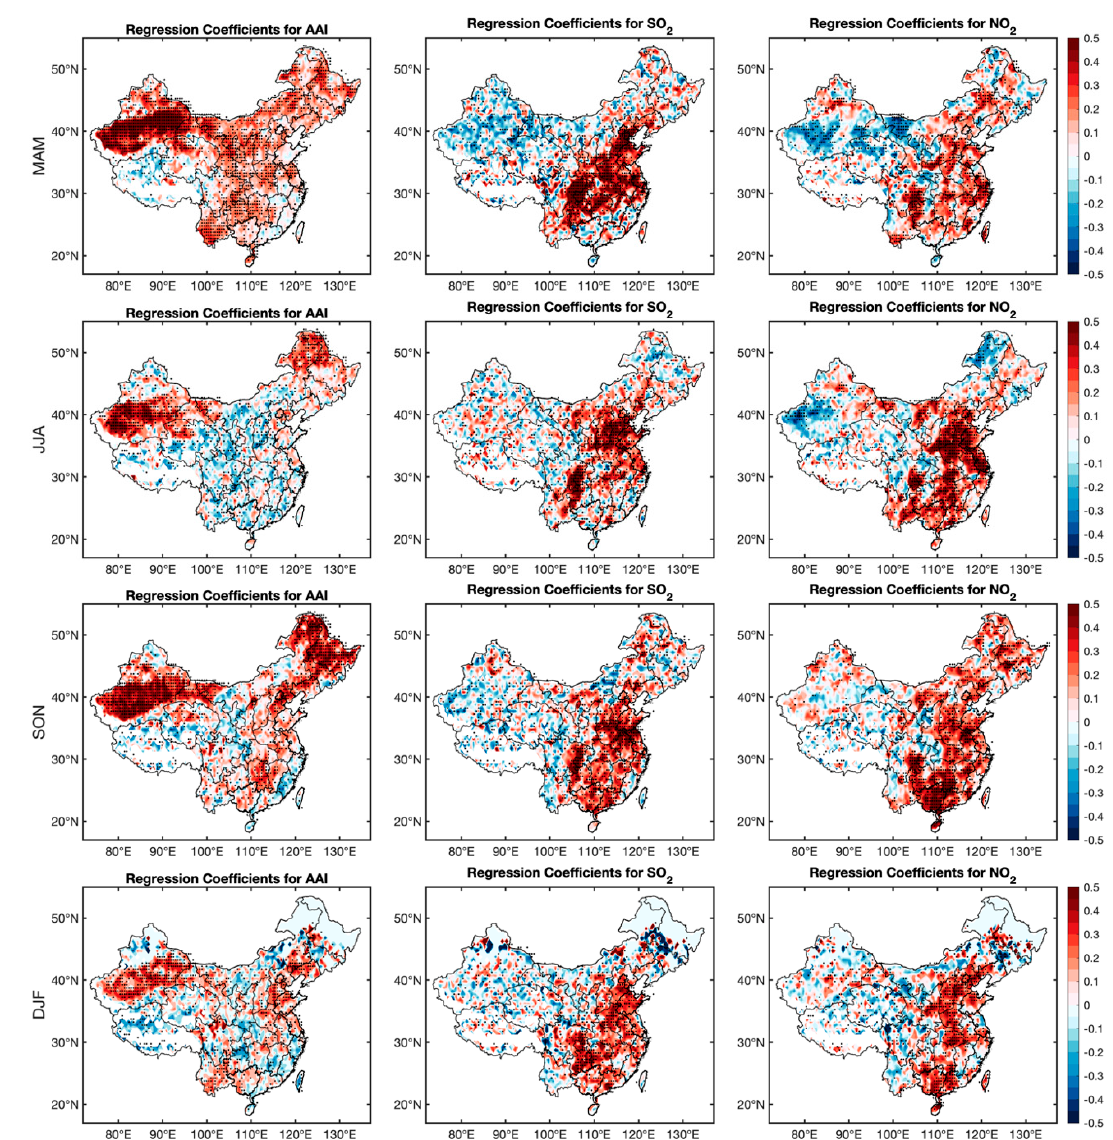
Figure 14. Distribution of the regression coefficients for AAI, SO 2 , and NO 2 from the seasonal